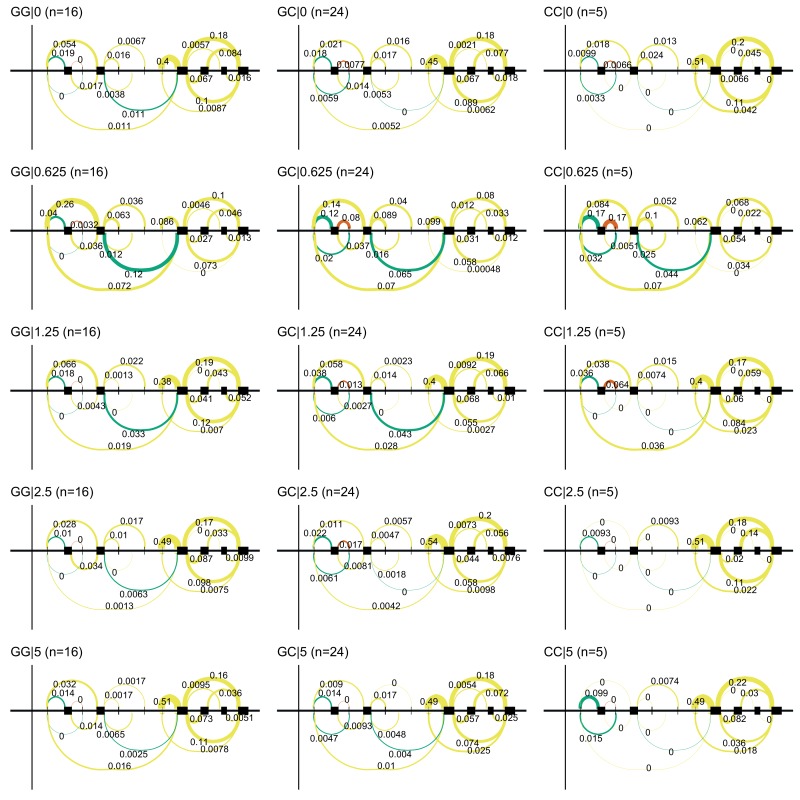
Alternative TSS use in NDUFAF6 on doxorubicin exposure.Doxorubicin exposure results in the use of a downstream alternative TSS for NDUFAF6 which uncovers an association between rs896853 genotype and inclusion of the exon at chr8:94975318–94975415.